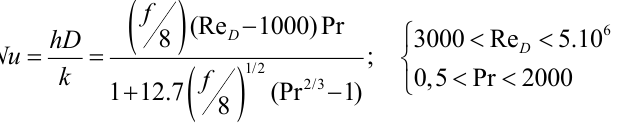
Figure 15. Estimative of discretization error of direct problem. Theoretical analysis can also be worthwhile to compare the theoretical heat flux and the heat flux obtained by the inverse approach. The hypothesis in theoretical heat